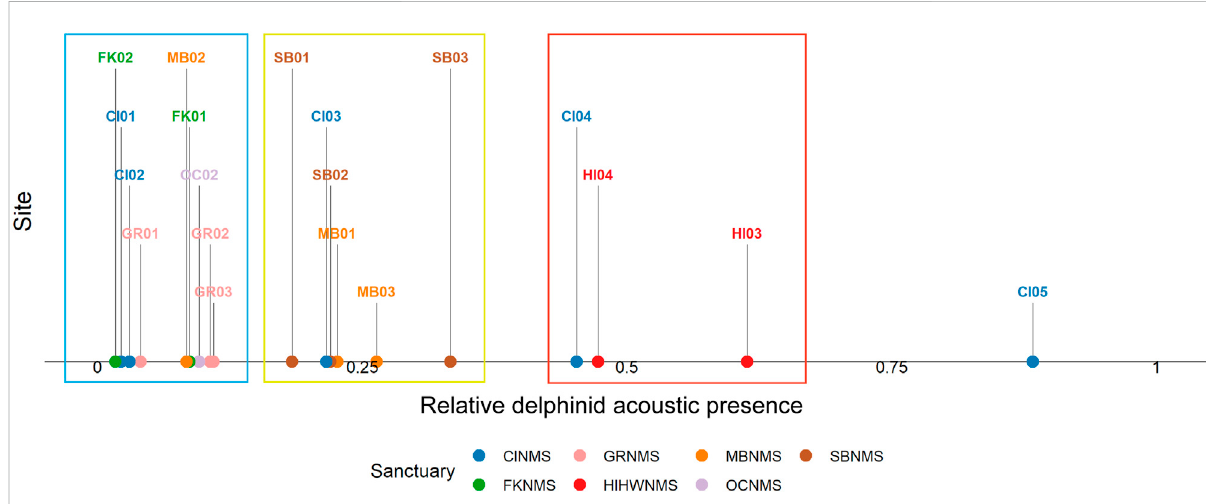
FIGURE 4 The ratio of hourly delphinid whistle presence normalized by recording effort (0 – 1) from 1 June 2019 to 31 May 2020 at each passive acoustic recording siteacross seven NMS,dividedinto three main regions: EastCoast Region United States (US) — StellwagenBank National Marine Sanctuary (SBNMS), Gray ’ s Reef National Marine Sanctuary (GRNMS), Florida Keys National Marine Sanctuary (FKNMS); West Coast Region US - Olympic Coast National Marine Sanctuary (OCNMS), Monterey Bay National Marine Sanctuary (MBNMS), Channel Islands National Marine Sanctuary (CINMS) and Hawai ʻ i Region US - Hawaiian Islands Humpback Whale National Marine Sanctuary (HIHWNMS). The sites with low ratios of delphinid acoustic presence are highlighted within the blue box, medium ratios within a yellow box, and high ratios in a red box. CI05 was an outlier compared to the other sites with a very high ratio of delphinid acoustic